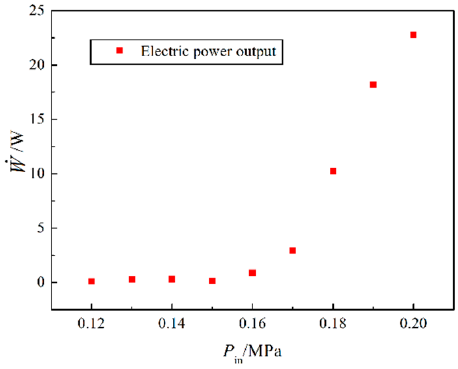
Figure 13. Electric power output of FPE ‐ LG.